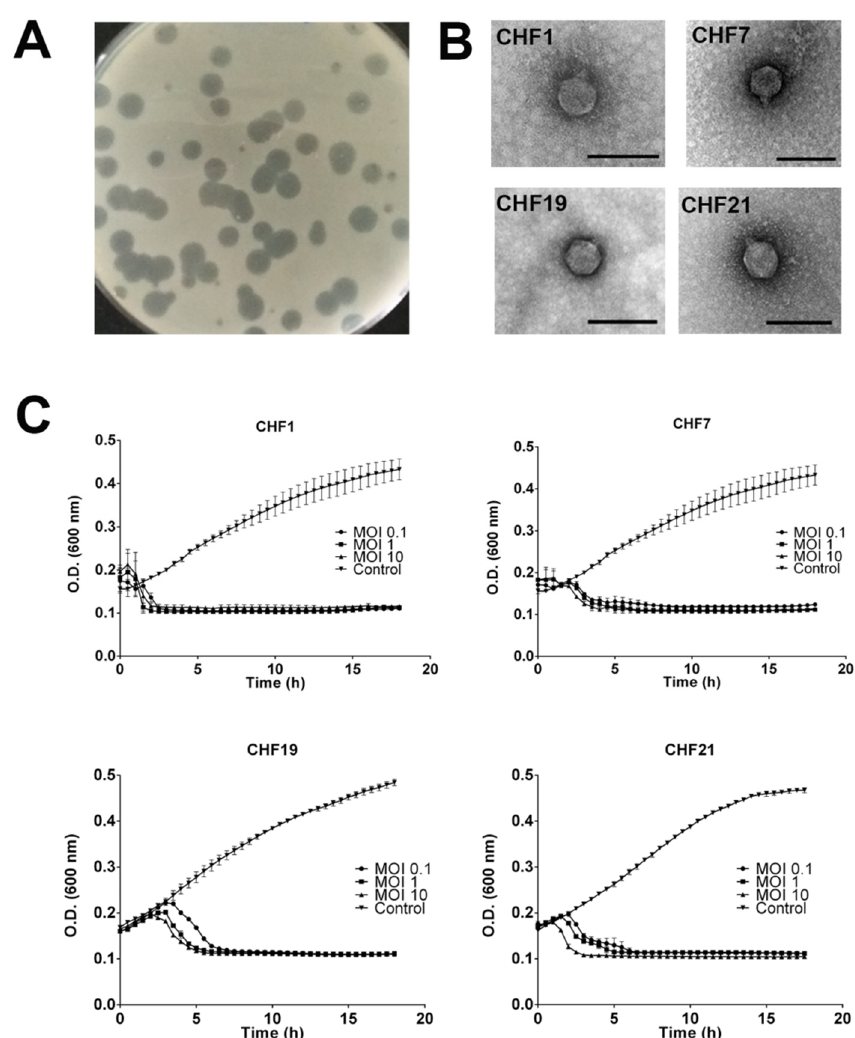
Figure 2. The morphology and lytic activity of selected Psa bacteriophages. ( A ) Lytic plaques of the phage CHF1 in a lawn of Psa strain 889. The rest of the selected phages presented the same lytic plaque morphology. ( B ) Transmission electron micrographs of the phages chosen. Scale bar, 100 nm. ( C ) Infection curves with the different selected phages and the corresponding Psa host with different multiplicity of infections (MOIs) (0.1, 1, and 10). The bacterial population was followed by OD (600 nm) determinations for 18 h. The Psa strain 889 was used for phages CHF1, CHF7, and CHF21, and the strain Psa 233 for phage CHF19. The controls corresponded to the bacterial cultures without the addition of phages. The experiments were performed in triplicate and standard deviation bars are shown.